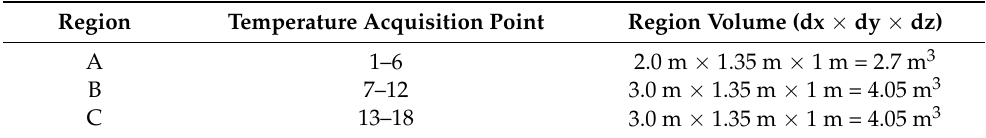
Table 4. Region volume of each temperature acquisition point.